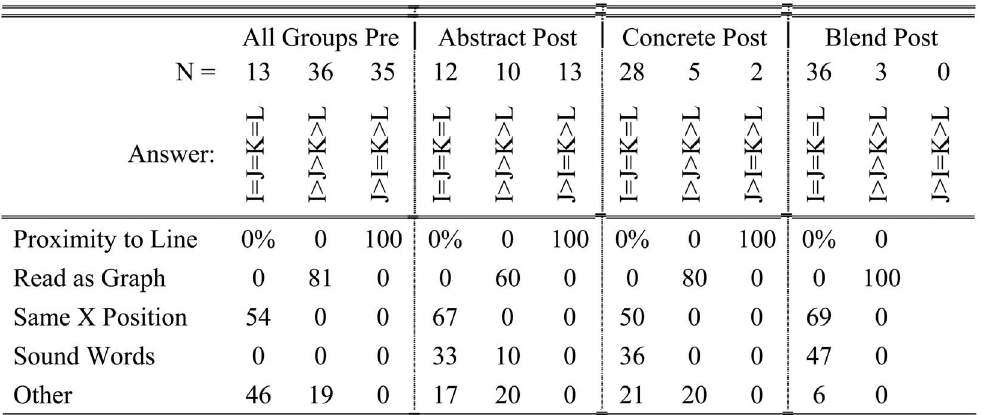
TABLE II. Coded student explanations on question 1 from the across-domain study pre- and post-tests.